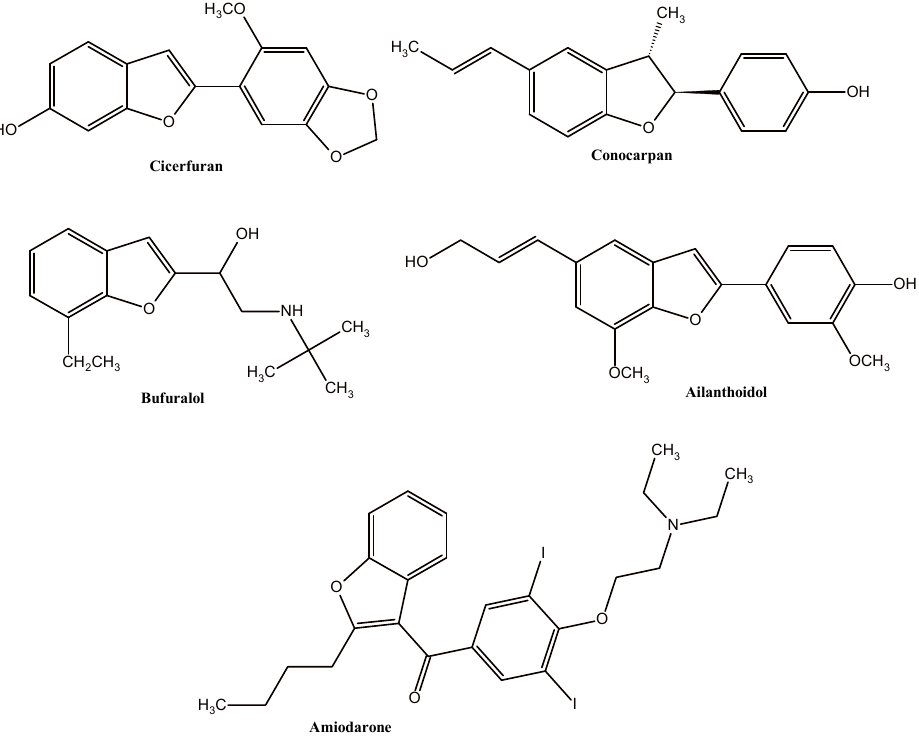
Figure 1. Structures of natural and synthetic benzofuran derivatives with biological activity.